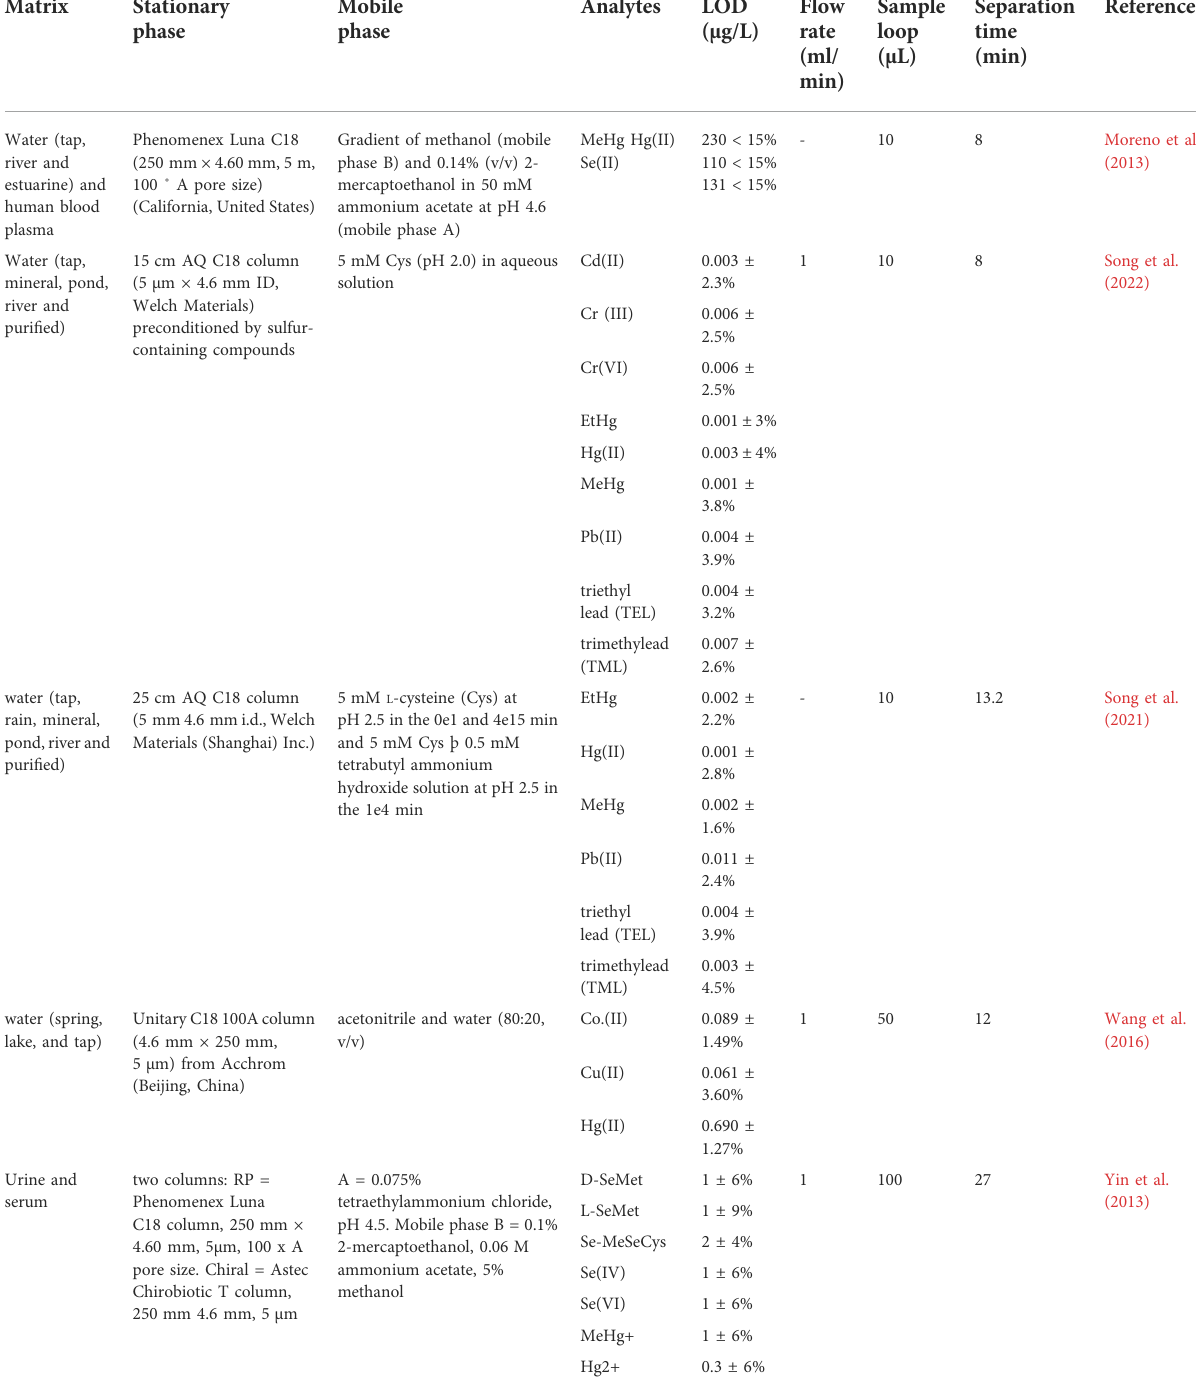
TABLE 4 HPLC conditions for the determination of low concentrations of various element